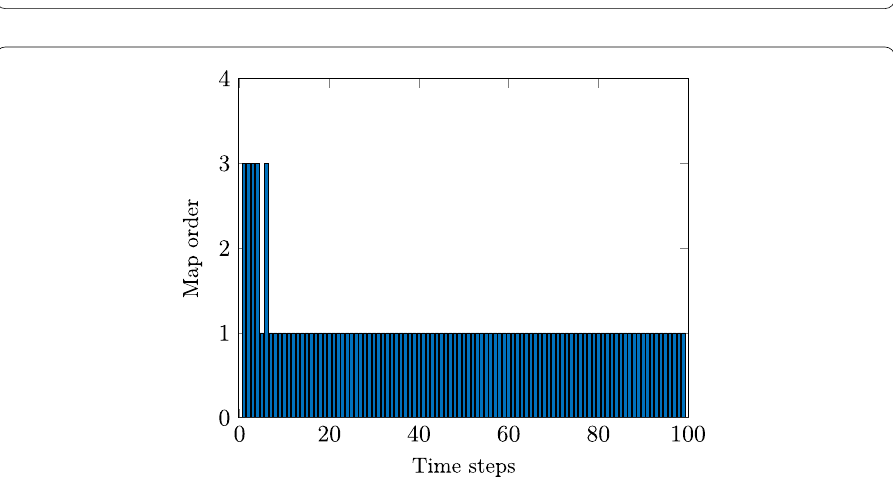
Fig. 24 Map order required at each assimilation time step - Case